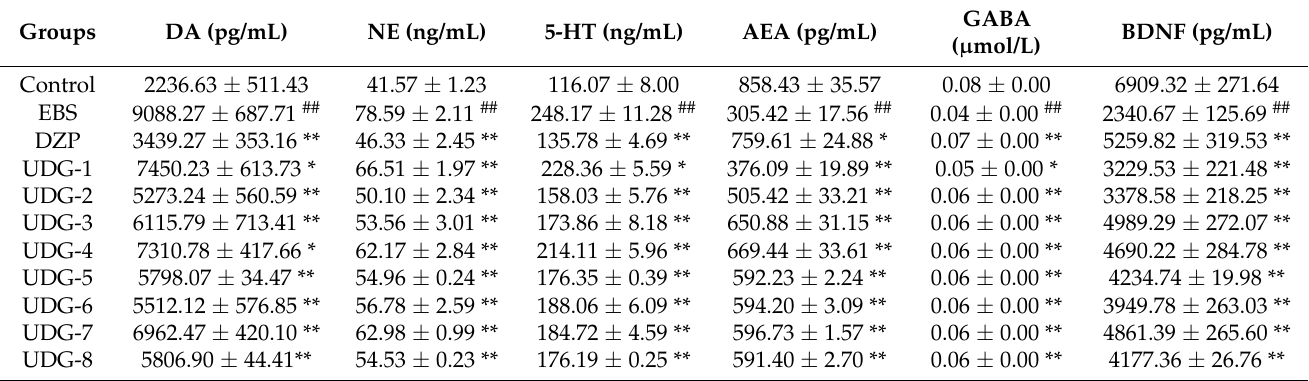
Table 3. Uniform designed experiment—multiple pharmacodynamic indicators in brains ( n = 8–10; mean ±